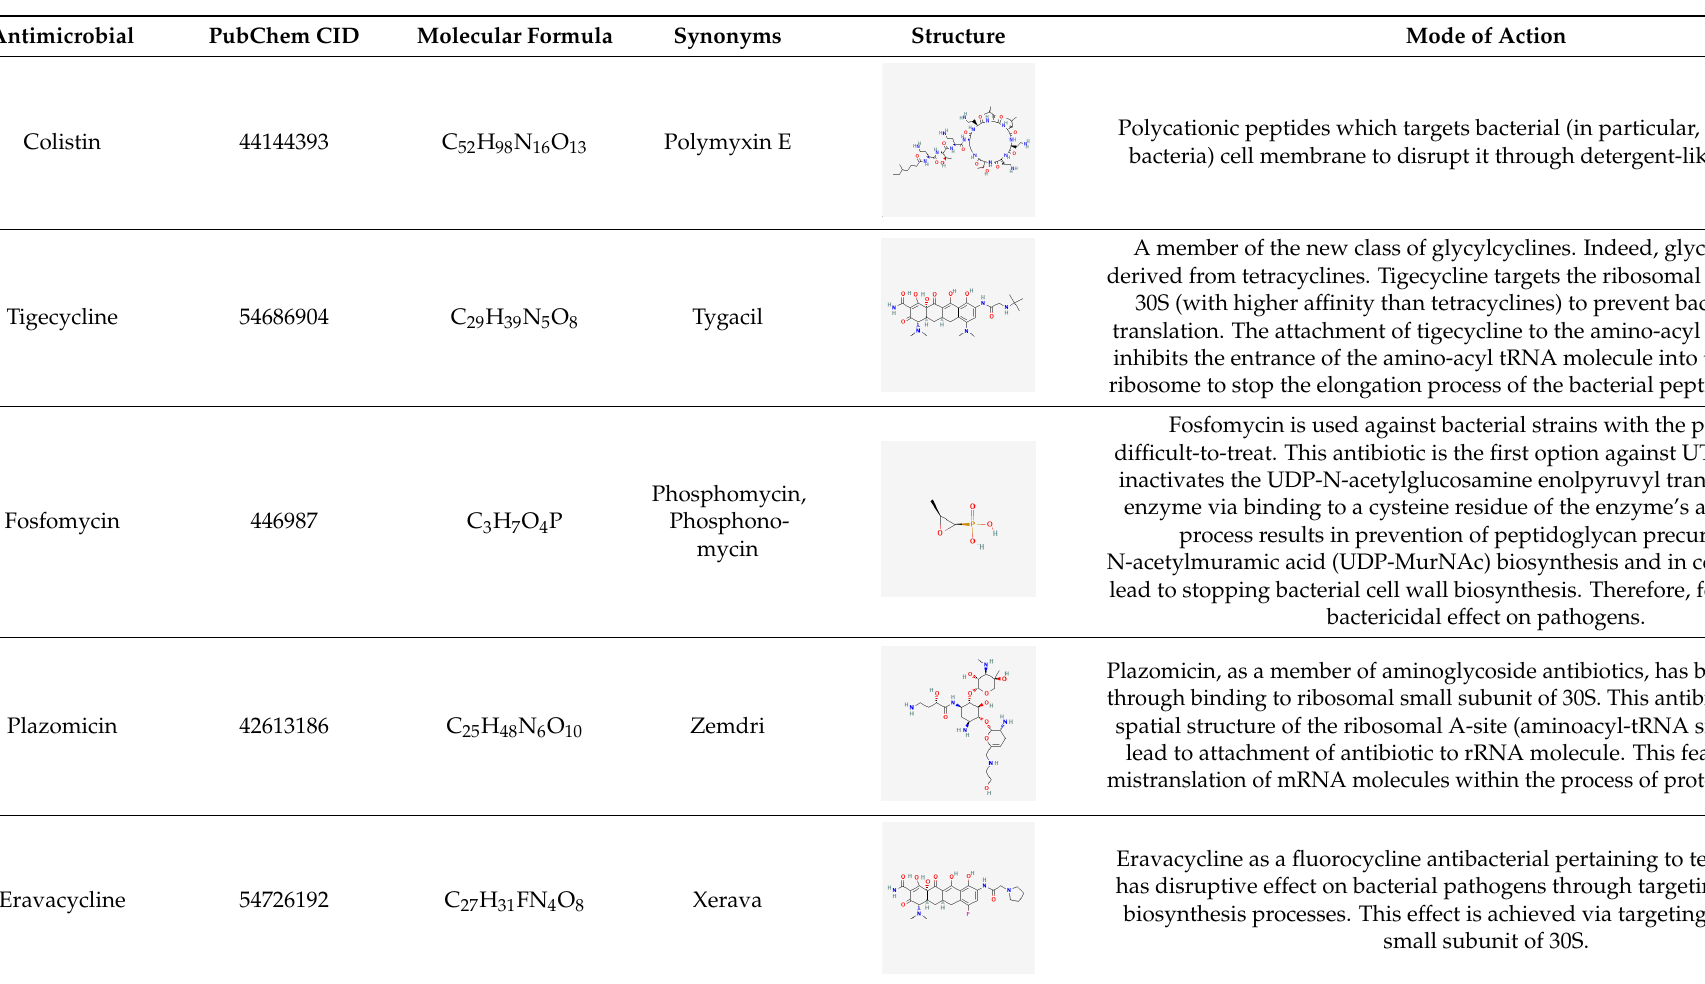
Table 1. General Characteristics of Antimicrobials [155].